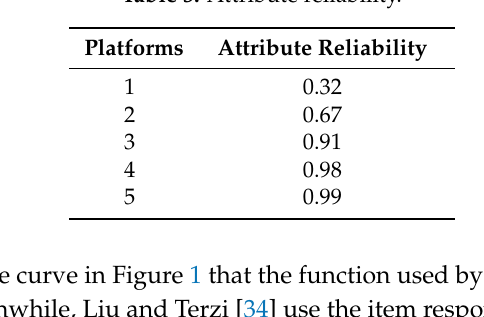
Table 3. Attribute reliability.